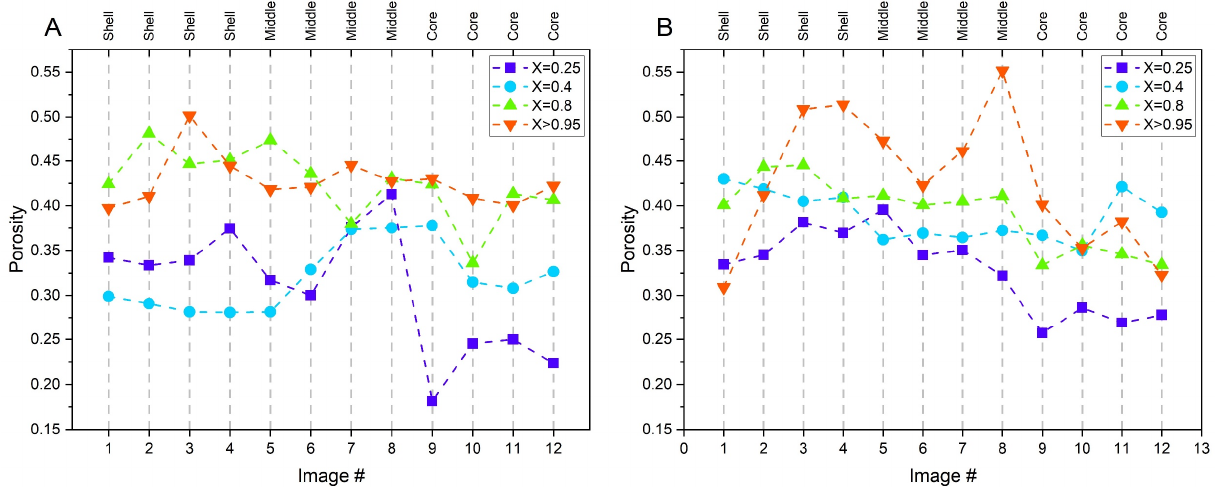
Figure 7. Porosity of 25%, 40% and 80% partially reduced pellet as well as >95% reduced pellet obtained using ( A ) H 2 & ( B ) H 2 /CO = 75/18 gas mixture.